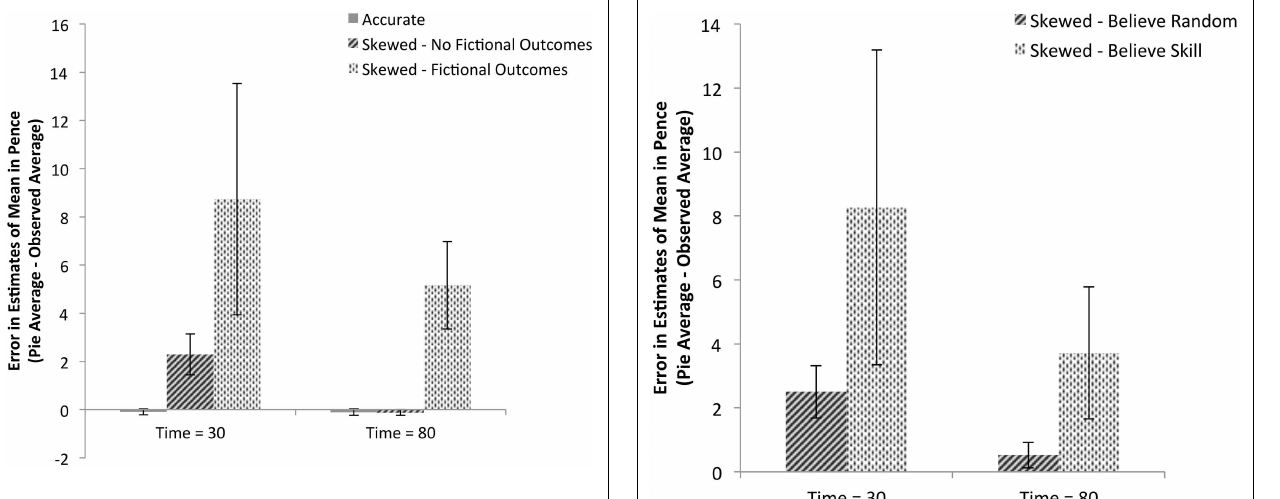
FIGURE 4 | Mean error in payout estimation based on condition and belief in fictional outcomes. Each participant’s mean observed payout for each machine was subtracted from each participant’s pie chart estimate of mean payout for that machine to calculate errors in estimation.The data are split based on whether the participant persisted throughout the game in including the fictional higher-value outcomes of 15, 20, 25, and 100 pence; 8 of 26 participants given skewed payout tables included the fictional outcomes; no participants given accurate payout tables did so.Values greater than zero indicate overestimation and values close to zero indicate accurate estimation. Errors for both the left and right machines were averaged resulting in one error measure per participant per judgment during machine play.